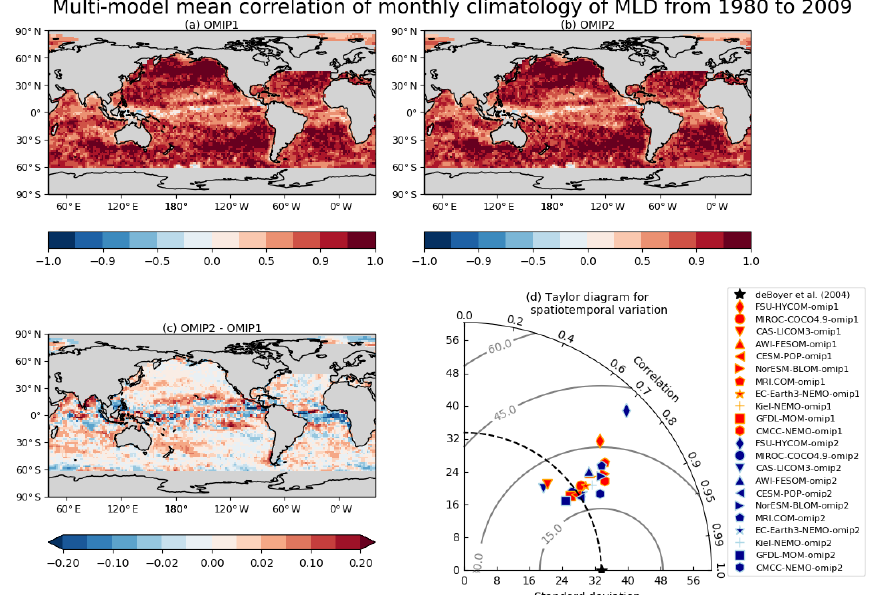
Figure E5. Multi-model mean correlation coefficients of monthly climatology of mixed layer depth (MLD) for the period 1980–2009 between simulation and de Boyer Montégut et al. (2004). (a) OMIP-1, (b) OMIP-2, (c) OMIP-2 − OMIP-1. (d) Taylor diagram of the total space–time pattern variability of the monthly climatology of MLD of OMIP-1 and OMIP-2 simulations relative to de Boyer Montégut et al. (2004), with standard deviations expressed in units of meters. See Figs. S61–S63 for results of individual models.